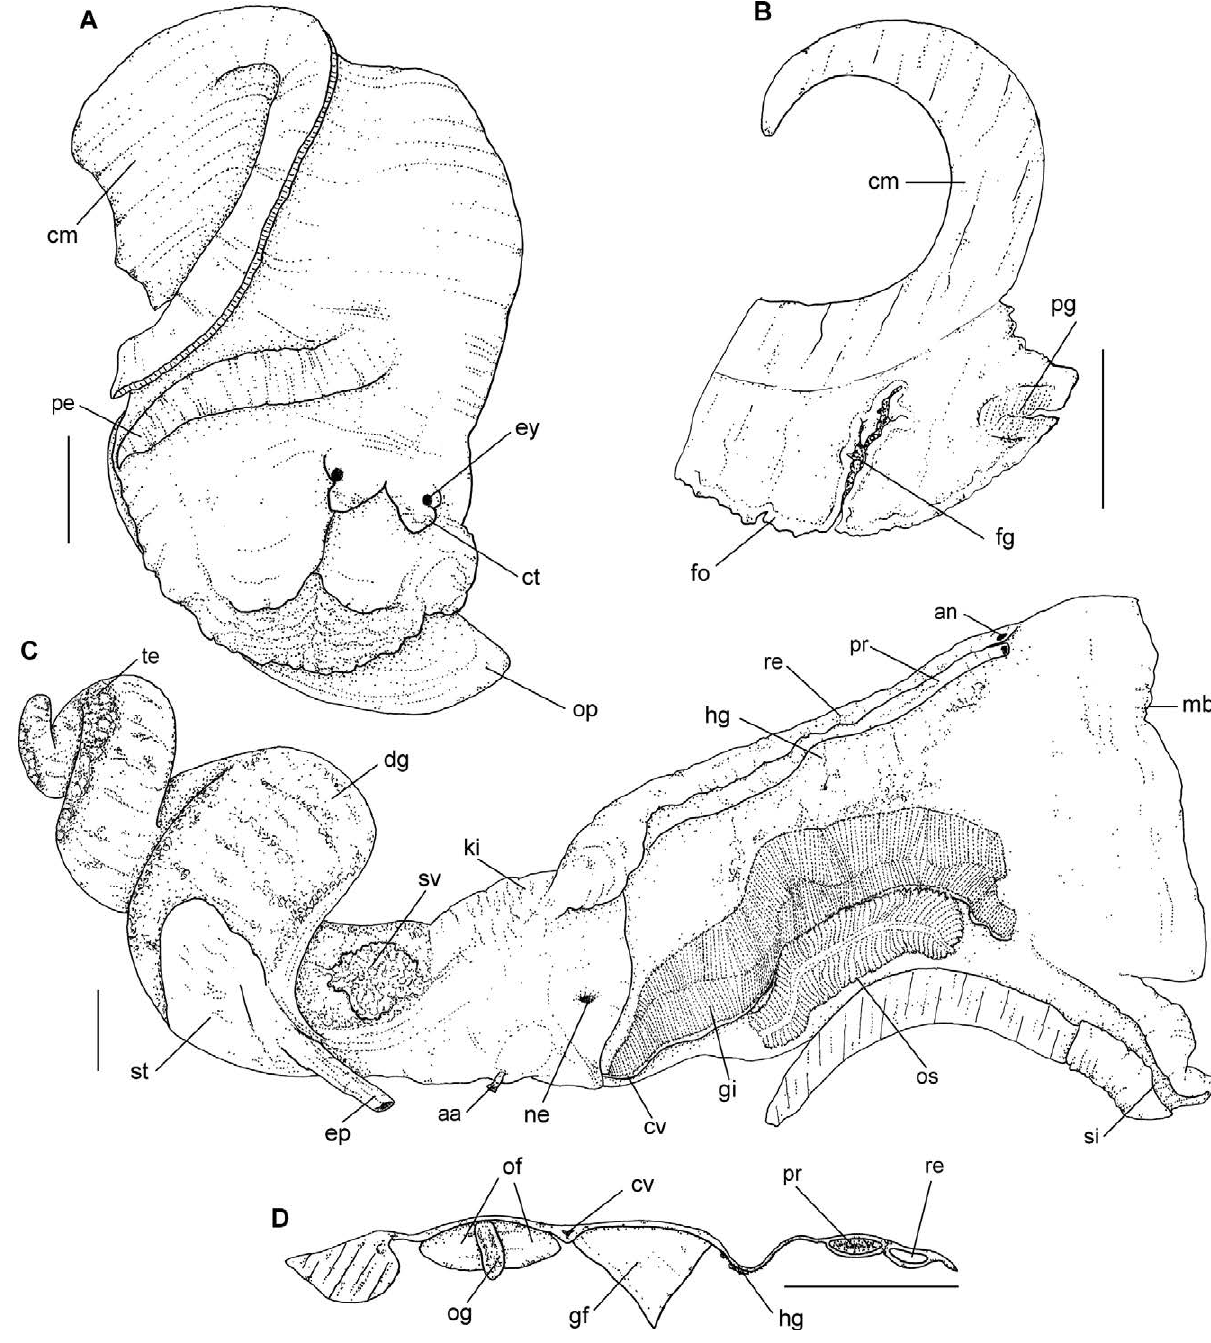
Fig. 2. – Pustulatirus ogum . A, head-foot mass in dorsal view; B, longitudinal section of head-foot mass, female; C, roof of pallial cavity in ventral view, male; D, transverse section of roof of pallial cavity. Abbreviations: aa, anterior aorta; an, anus; cm, columellar muscle; ct, cephalic tentacle; cv, ctenidial vein; dg, digestive gland; ep, posterior esophagus; ey, eye; fg, female cement gland; fo, foot; gf, gill filament gi, gill; hg, hypobranchial gland; ki, kidney; mb, mantle border; ne, nephrostome; of, osphradium filament; og, osphradium ganglia; op, opercu- lum; os, osphradium; pe, penis; pg, pedal gland; pr, prostate; re, rectum; si, siphon; st, stomach; sv, seminal vesicle; te; testis. Scale bars: 2